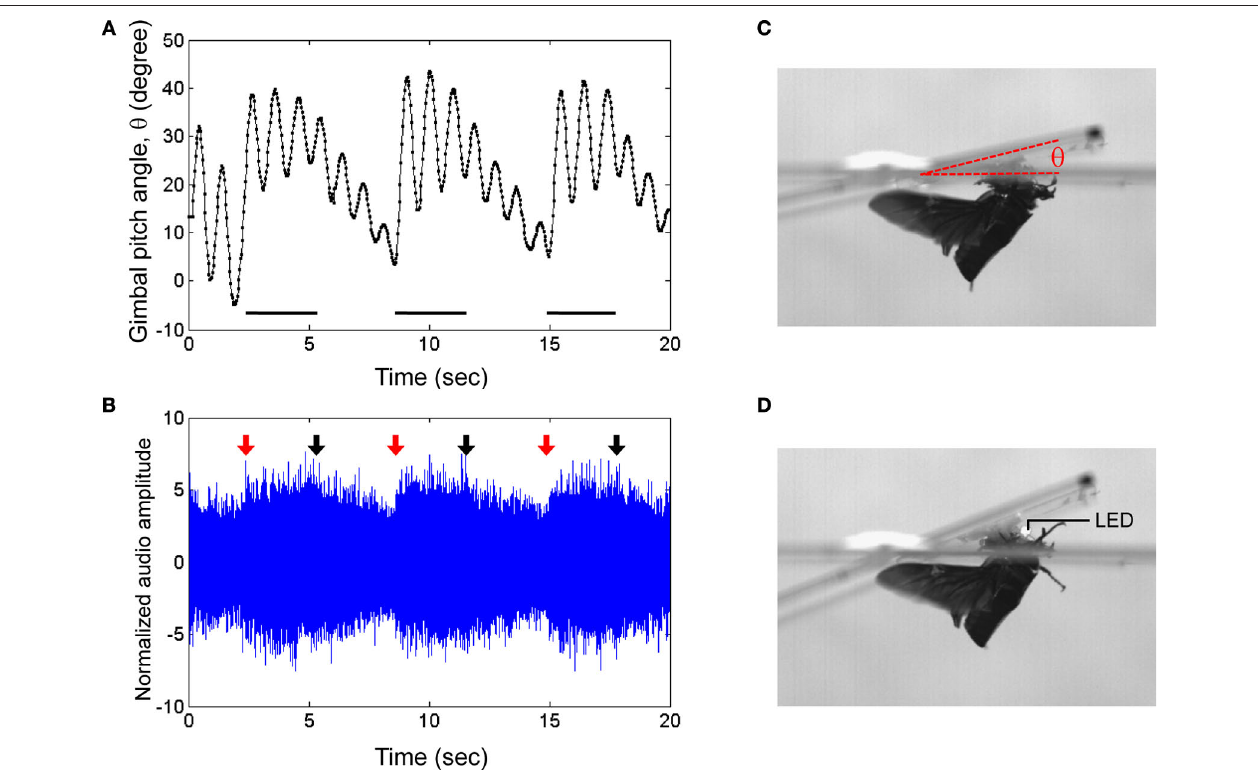
FIgure  | elevation control of Cotinis texana beetle tethered on a custom pitching gimbal. Brain stimulus altered the gimbal pitch of the beetle. (A) Gimbal pitch angle with the mounted beetle during alternating periods of un-stimulated and stimulated flight. Horizontal bars indicate durations of the stimuli (3 s each); a 10-Hz, 3.0 V pulse train whose waveform is identical to that in Figure A was applied during the indicated periods. (B) Audio recording corresponding to (A) . Red and black arrows indicate